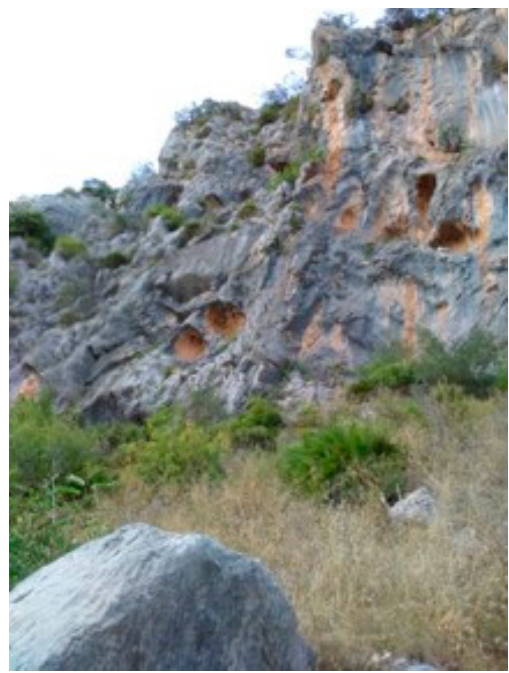
Figure 10. The stone for the rituals is oriented, precisely, towards her. The photo is taken by the author.